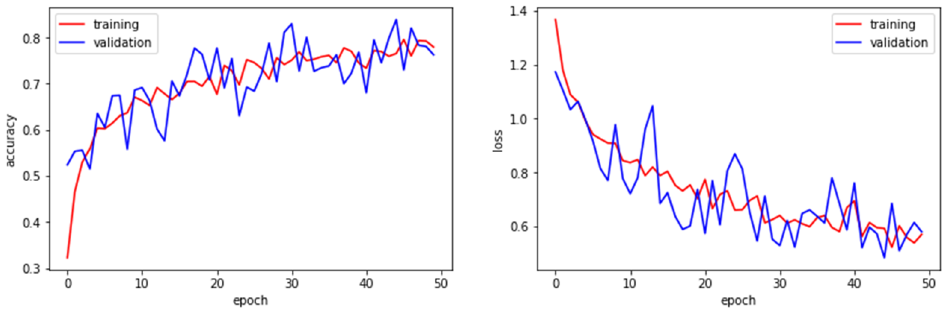
Figure 6. Accuracy and loss of MCNN6 training and verification (epoch = 50).